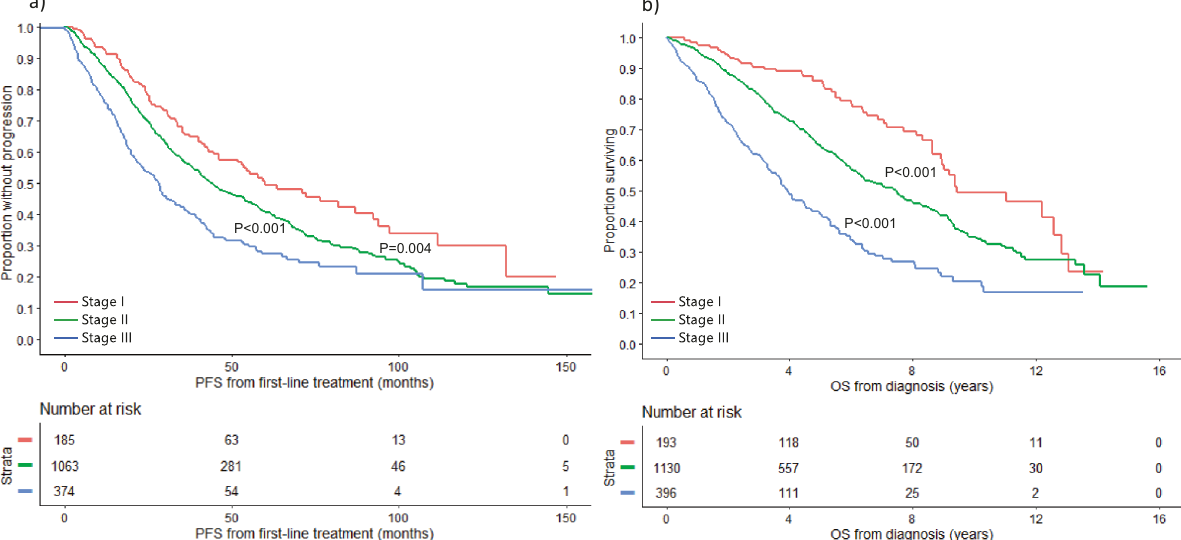
Fig. 1 PFS and OS based on the updated R-ISS. a PFS (months) and b OS (years) in MM patients with stage I (red curve), II (green), and III (blue curve) based on the updated R-ISS. MM multiple myeloma, OS overall survival, PFS progression-free survival, R-ISS revised international staging system. The P values for each pair of groups are presented between the corresponding 0.001) (Fig. 4a). In patients who underwent transplant, median OS was 11.3 (95% CI: 10.4 – 13.0), 9.7 (95% CI: 7.5 – 10.4), and 6.1 (95% CI: 5.6 – 8.8) years in the 3 groups, respectively ( P < 0.001) (Fig. 4b). Risk strati fi cation based on the MASS over 2 time periods Of all the patients included in the study, 1001 were diagnosed with MM prior to the year 2012, including 407 who had available data for staging by the MASS. Among those, 174 (43%), 128 (31%), and 105 (26%) patients had stage I, II, and III disease by MASS, respectively. The median PFS was 36.7 (95% CI: 32.1 – 46.0), 31.3 (95% CI: 26.6 – 36.4), 18.8 (95% CI: 13.3 – 21.8) months in the 3 groups, respectively ( P < 0.001). The OS in the 3 groups was 10.4 (95% CI: 8.8 – 11.5), 6.6 (95% CI: 5.5 – 8.7), and 3.3 (95% CI: 2.3 – 4.2) years, respectively ( P < 0.001). Of the 1555 patients diagnosed with MM after year 2012, 920 had available data for MASS staging. Among those, 302 (33%), 314 (34%), and 304 (33%) patients had stage I, II, and III disease by MASS, respectively. The median PFS was NR (95% CI: 74.5-NR), 75.6 (67.4-NR), and 43.4 (95% CI: